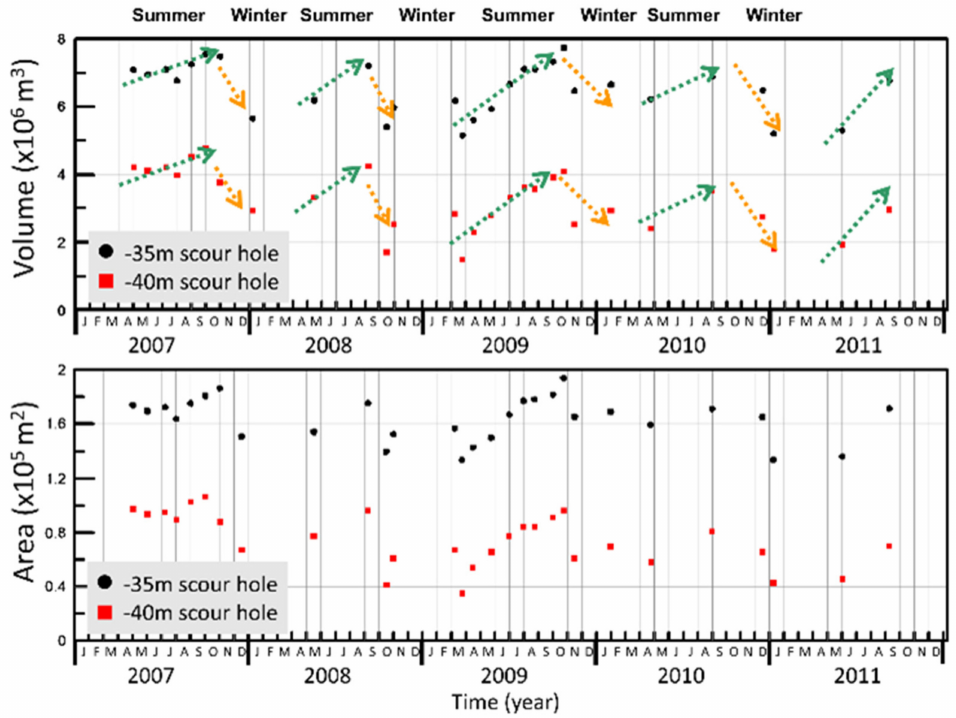
Figure 11. The area and volume of the − 35 m and − 40 m scour holes near the West Breakwater.